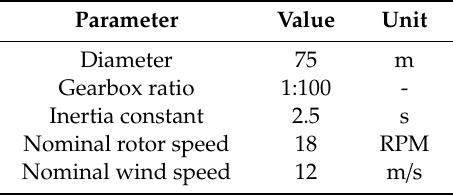
Table 1. Parameters of the wind turbine.